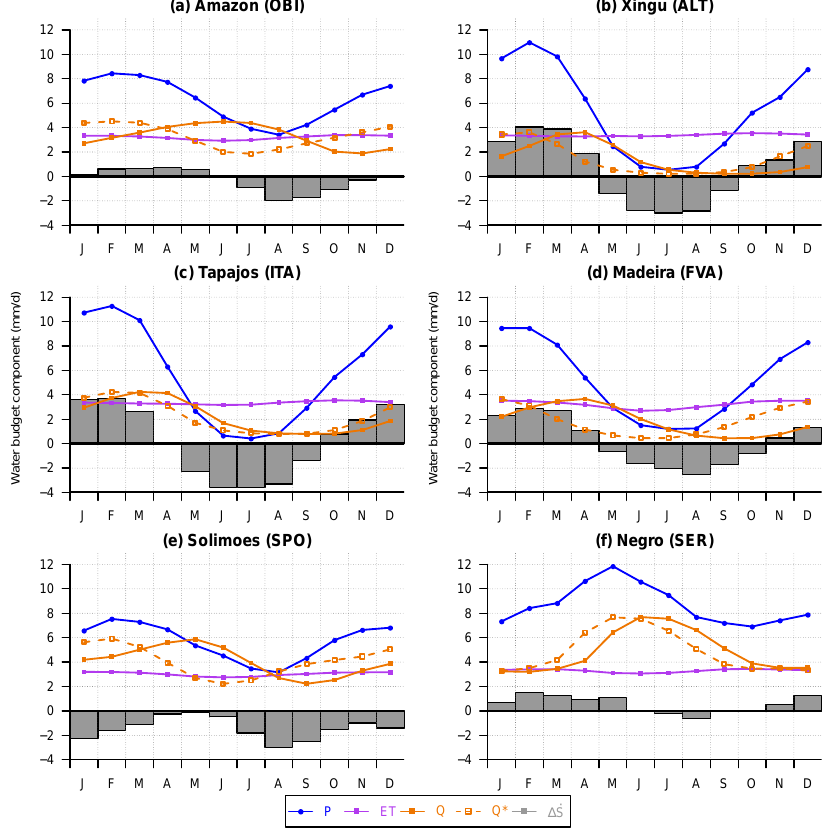
Figure 2. Monthly mean seasonalities of the water budget components (mmd − 1 ) from observations, for the Amazon Basin and its sub- Fig. 2. Monthly mean seasonalities of the water budget components ( mmd –1 ) from observa- basins, averaged over the period 1980–2008. Q ∗ is the equivalent runoff as the discharge Q time series, back-shifted using the empirical lag. tions, for the Amazon basin and its sub-basins, averaged over the period 1980-2008. Q ∗ is The change in total water storage ˙ 1S is estimated as the residual of P -ET- Q ∗ . the equivalent runoff as the discharge Q time-series, back-shifted using the empirical lag. The change in total water storage ˙∆ S is estimated as the residual of P-ET-Q*.